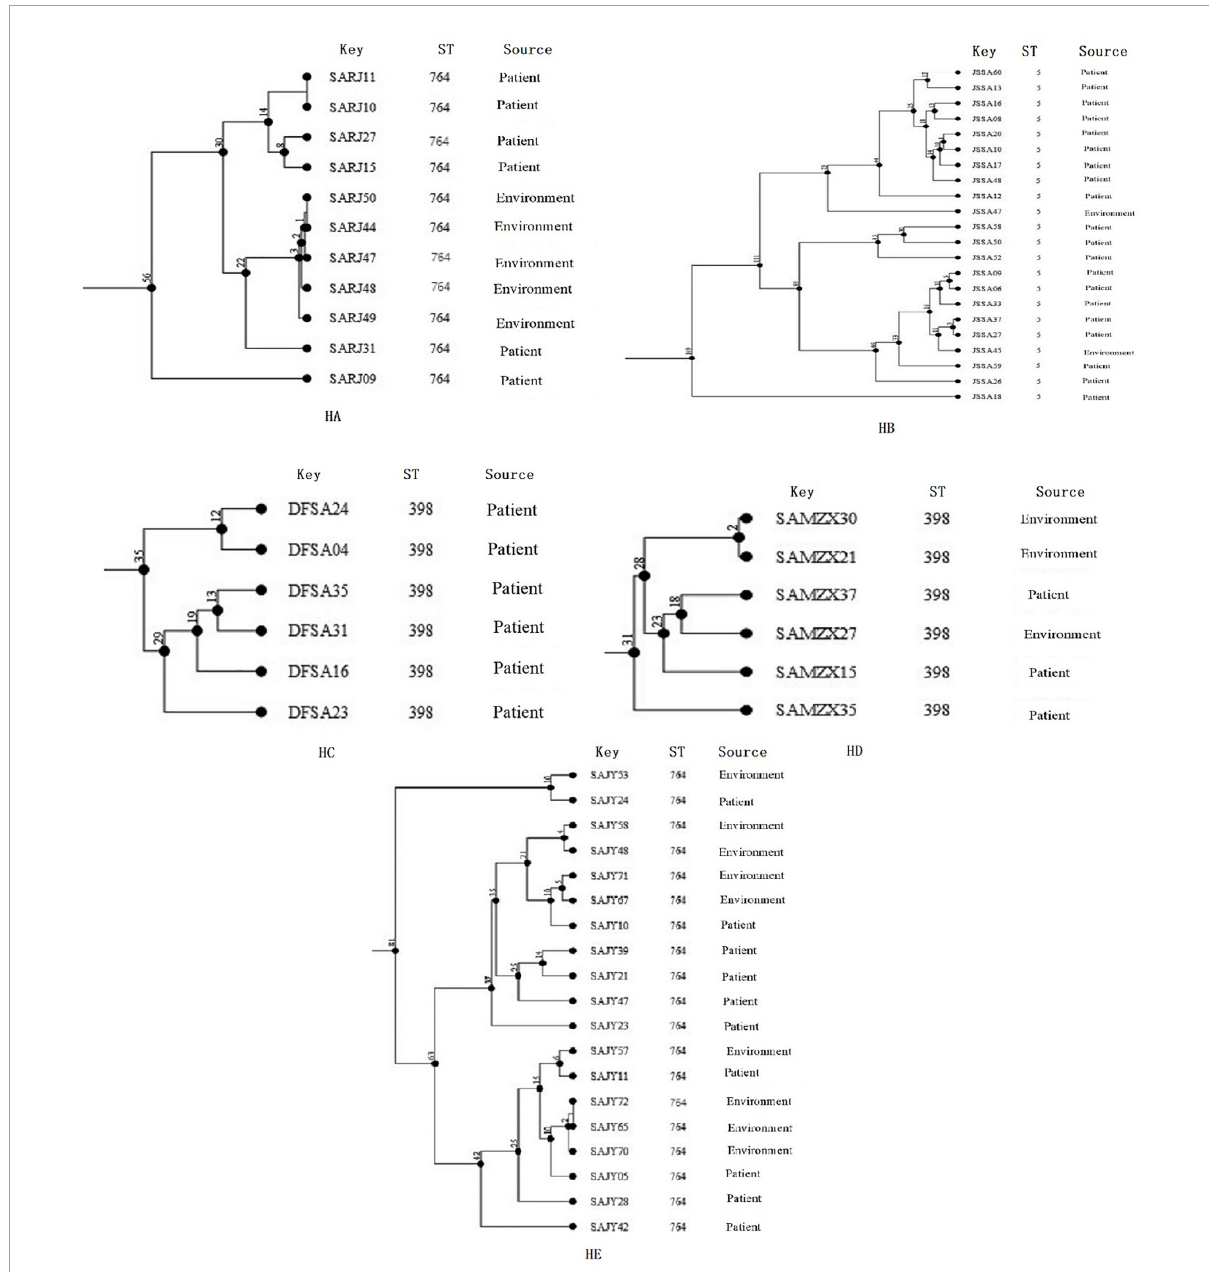
FIGURE4 Clustering of partial Methicillin-resistant Staphylococcus aureus (MRSA) isolates from five hospitals, respectively, based on core genome multilocus sequence typing (cgMLST). The multiplication by one in the tree represents the number of different alleles among isolates. The corresponding data, including the name of these isolates (Key), ST, source (patient or environmental surface), and CL, are shown alongside the dendrogram to the